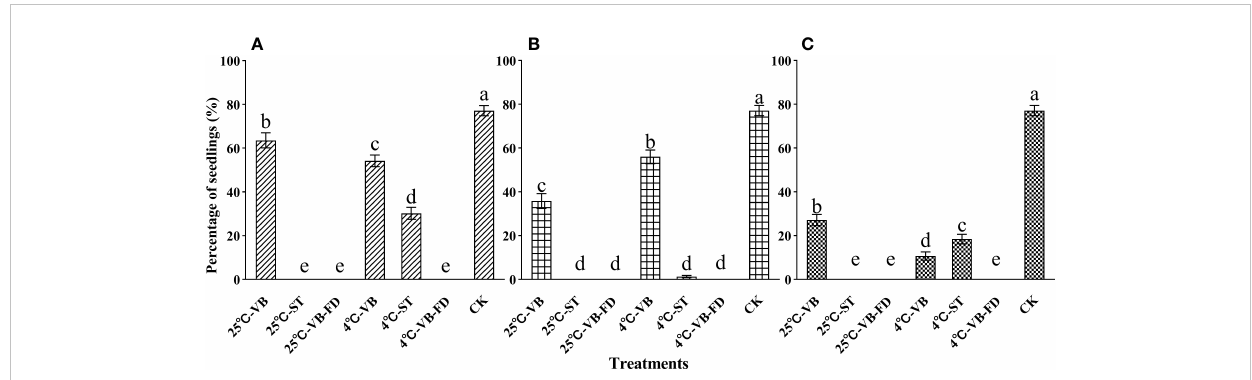
FIGURE 4 The percentages of seedlings (mean±SE) in different storage treatments (storage methods * temperatures * storage time) of seedfungus complexes of Dendrobium of fi cinale with fungal strain LQ at 60 days after sowing. The signi fi cant differences among storage methods at 4°C and 25°C for (A) 15, (B) 30 and (C) 45 days are shown by different lowercase letters at p < 0.05. VB, stored in valve bags; ST, stored in sealed tubes; VB-FD, stored in valve bags after freeze-drying; CK, TP-LQ seed-fungus complexes were sown without storage.